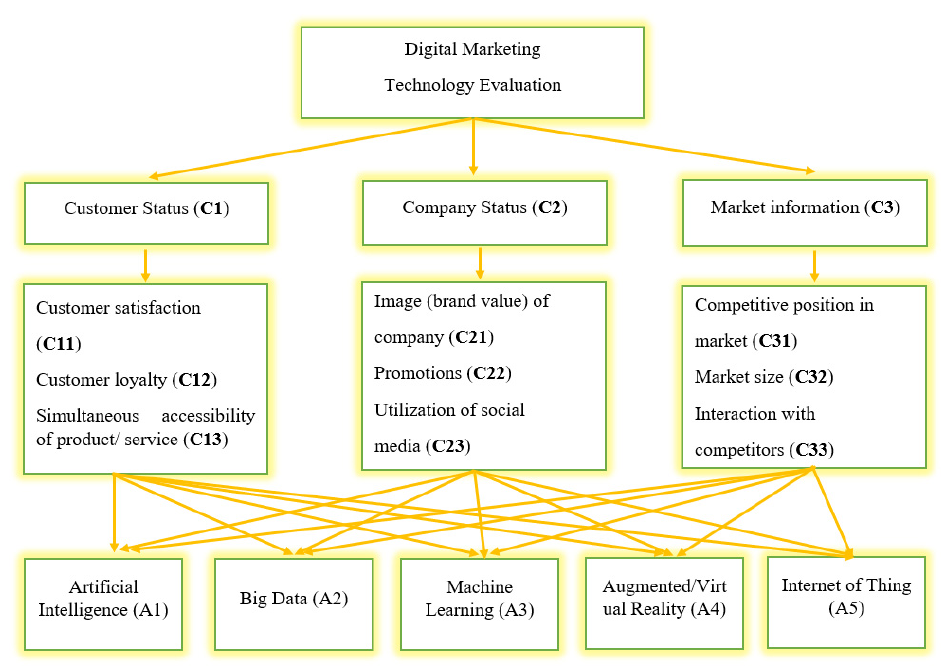
Figure 3. The devised AHP model for the evaluation process.